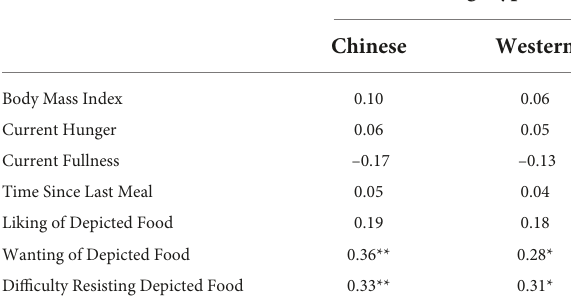
TABLE 4 Bivariate associations between self-report ratings and reward region cluster 1 differentiating Chinese versus Western food